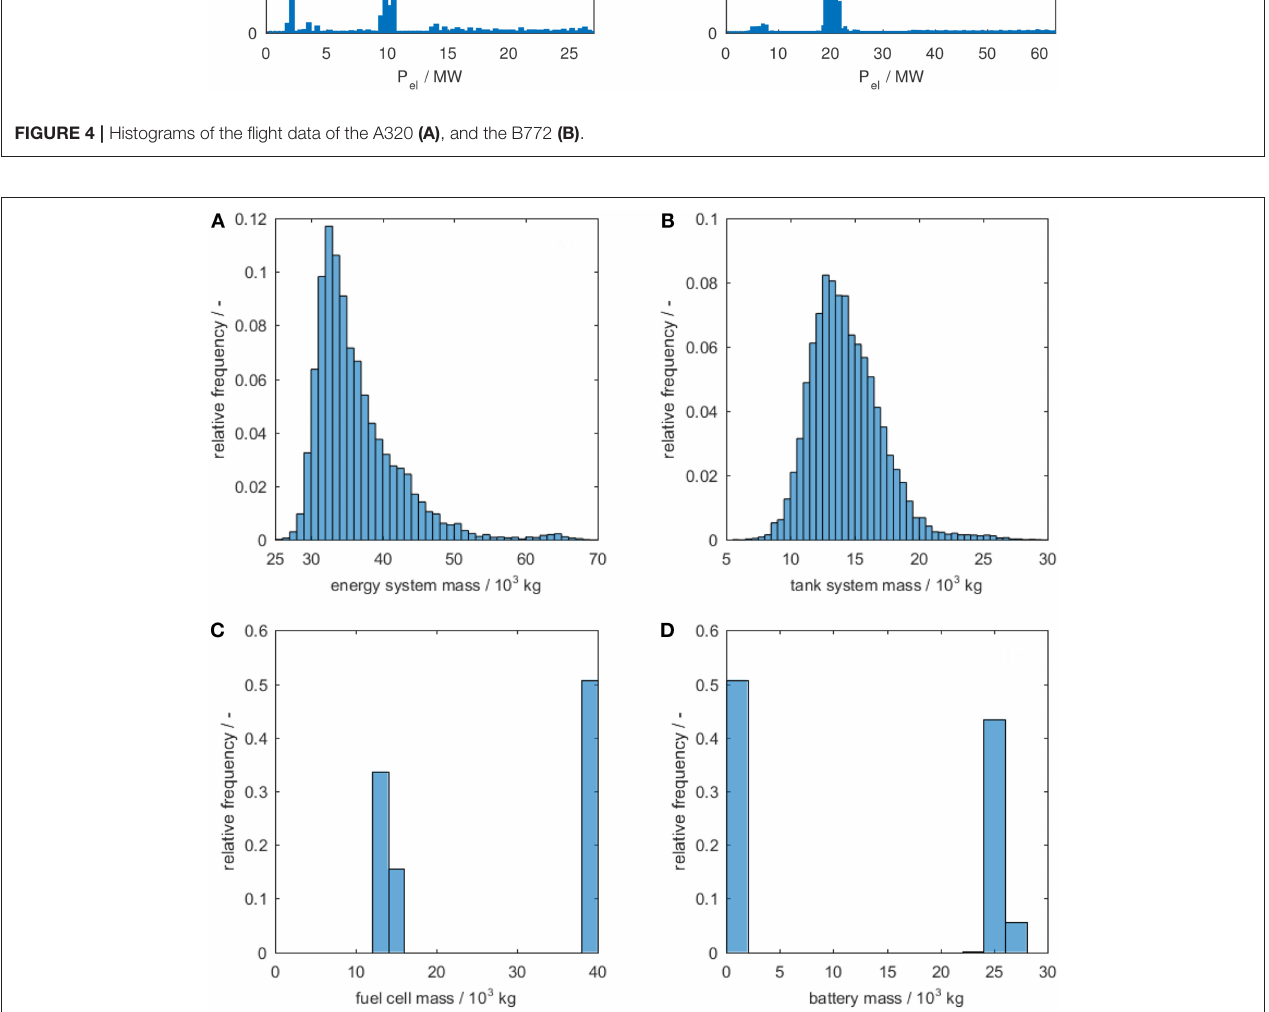
FIGURE 5 | Energy system design for the B772 for current fuel cell systems with a specific power of 1.6 kW/kg and advanced batteries with a specific energy of 0.8 kWh/kg. Distribution of: (A) the total mass of the energy system. (B) mass of the tank system (tank+hydrogen), (C) fuel cell mass and (D) battery